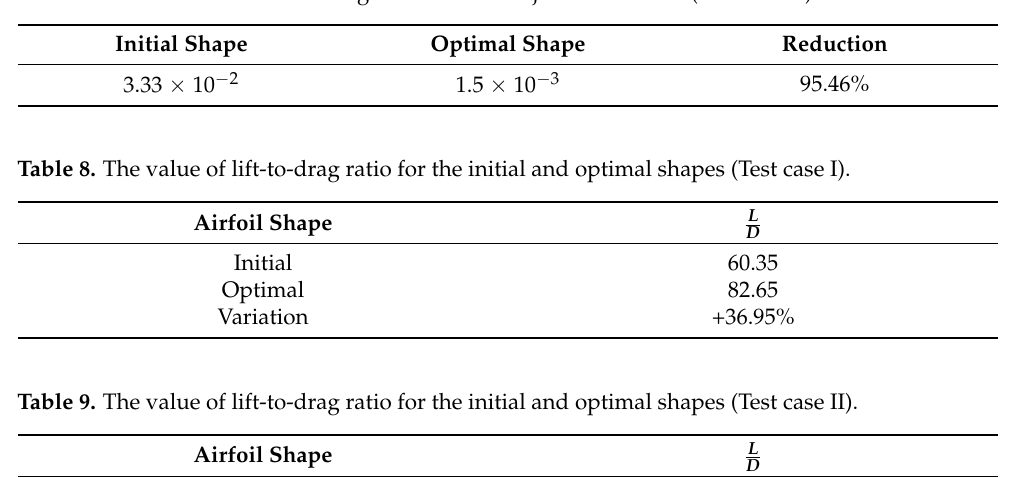
Table 7. Reduction in the norm of gradient of the objective function (Test case II).